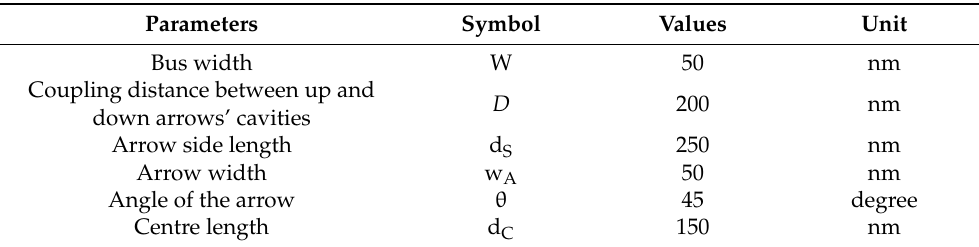
Figure 2. ( a ) Schematic diagram of the proposed plasmonic multi-channel bandpass filter structure with geometrical parameters found in Table 1; ( b ) Incident TM-mode field distribution with λ = 600 nm. Table 1. Dimensions of the proposed plasmonic multi-channel bandpass filter (up and down arrows are identical in geometry size).